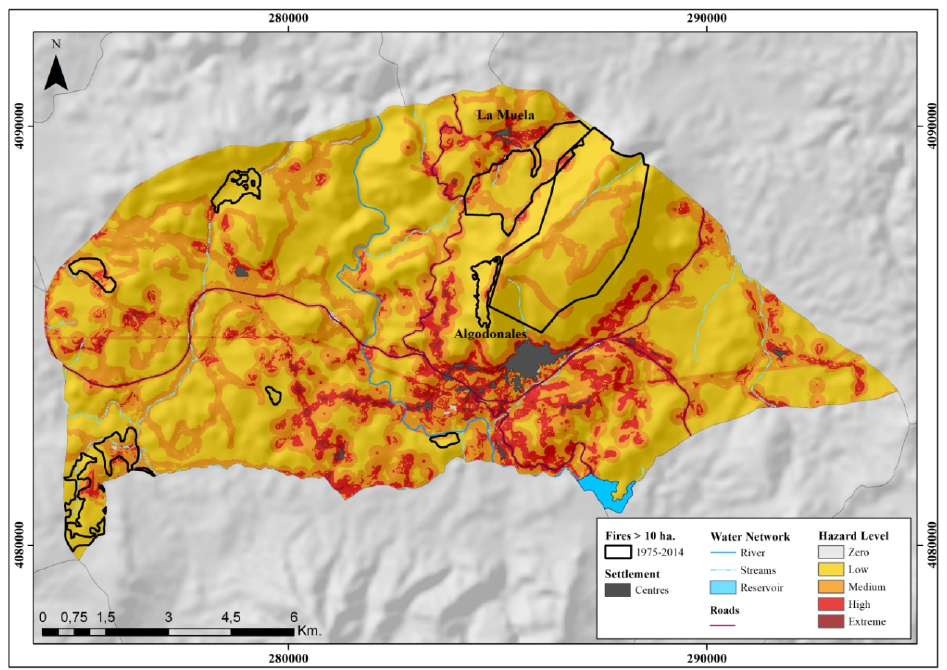
Figure 12. Final hazard map in July 2023 (Figure 8B) and occurred fires in the study area (Burned areas data extracted from REDIAM).